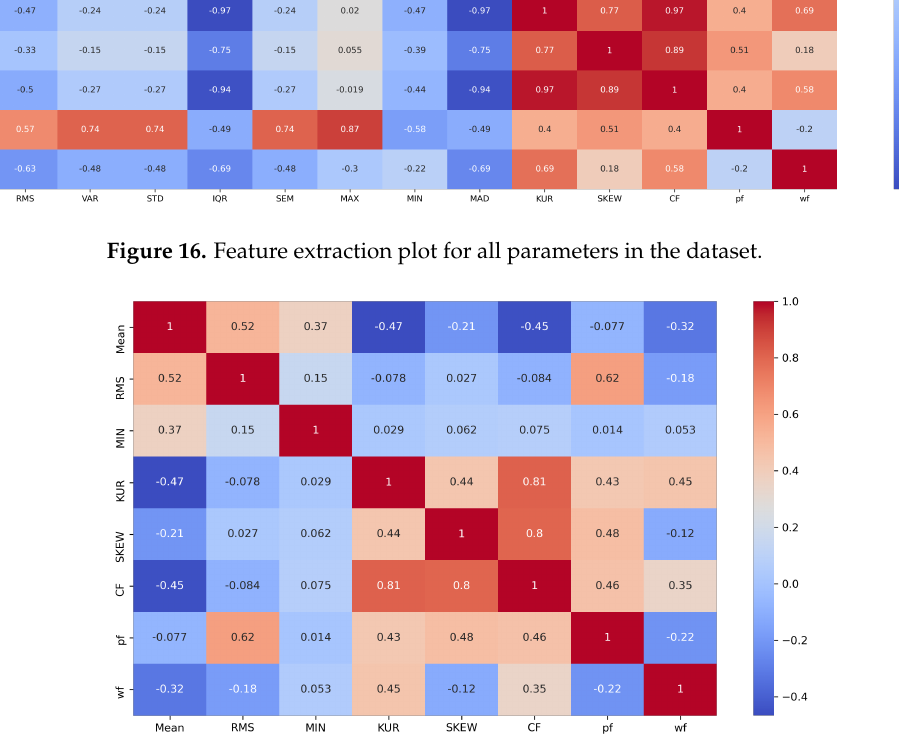
Figure 17. Feature selection plot for all parameters in the